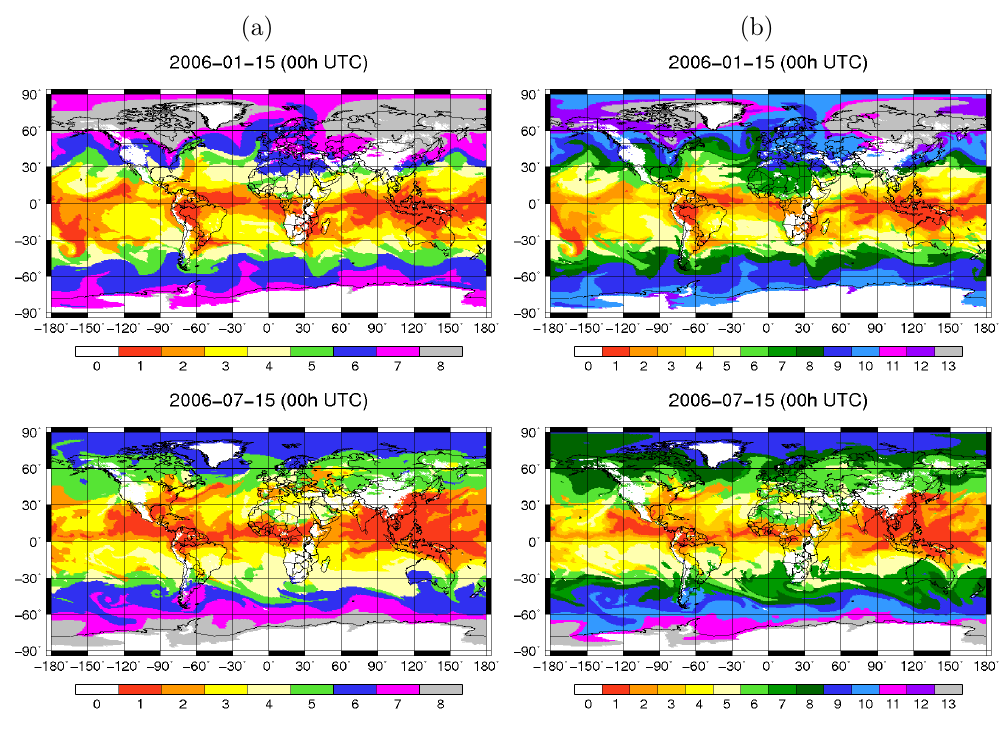
Figure 9. Unsupervised classification with EM-VII into 8 (a) and 13 (b) classes.